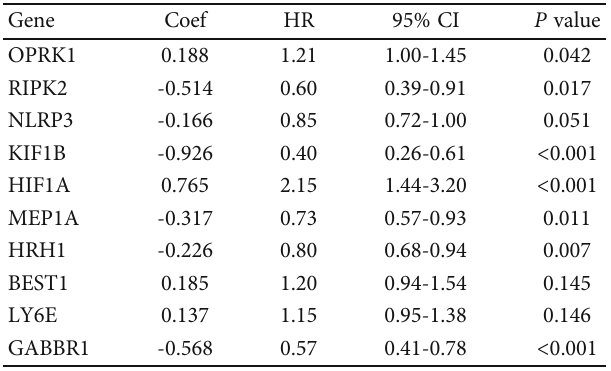
Table 1: The information of 10 OS-related IRRGs by multivariate Cox regression analysis.